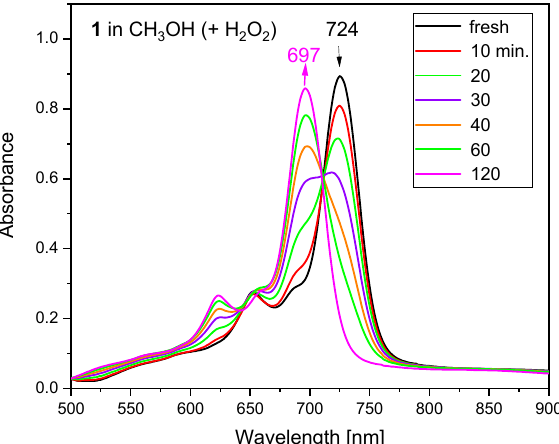
Figure 8. Spectral changes during the oxidation by H 2 O 2 of 5 × 10 − 6 mol [(SbPc) 4 (Sb 6 I 16 Br 6 )] in methanol. The Q bands at 724 nm and 697 nm are characteristic for the Sb III and for Sb V phthalocyanines, respectively.